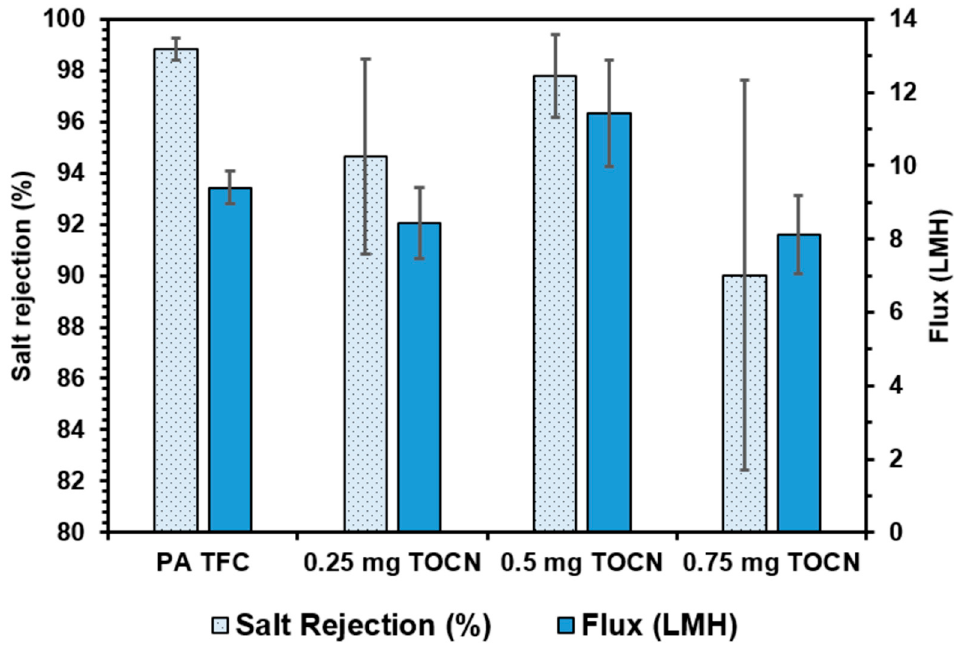
Figure 11. Flux and salt rejection results for TOCN containing TFN membranes fabricated using the vacuum filtration method.